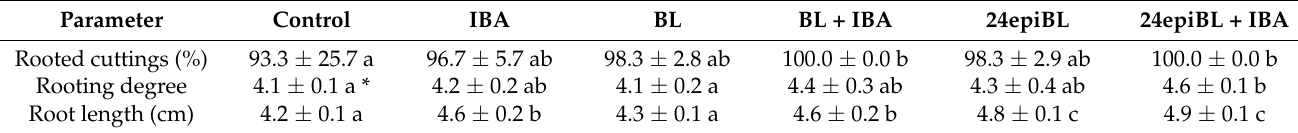
Table 4. Effect of brassinosteroids and auxin IBA on rooting of cuttings in Berberis thunbergii ‘Red Rocket’. Parameter